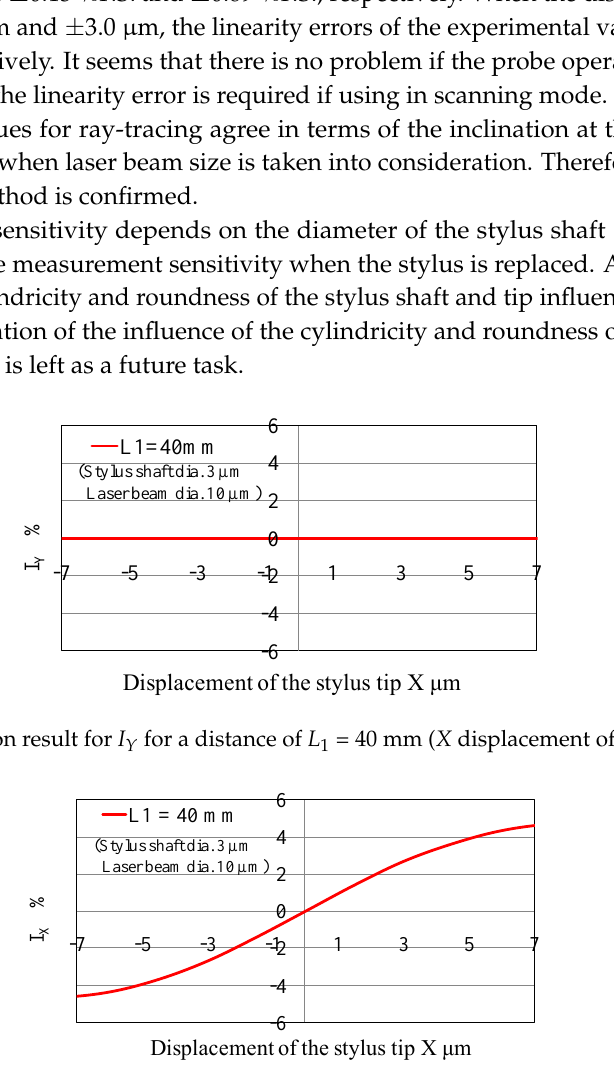
Figure 13. Simulation result for I X for a distance of L 1 = 40 mm ( X displacement of the stylus tip).